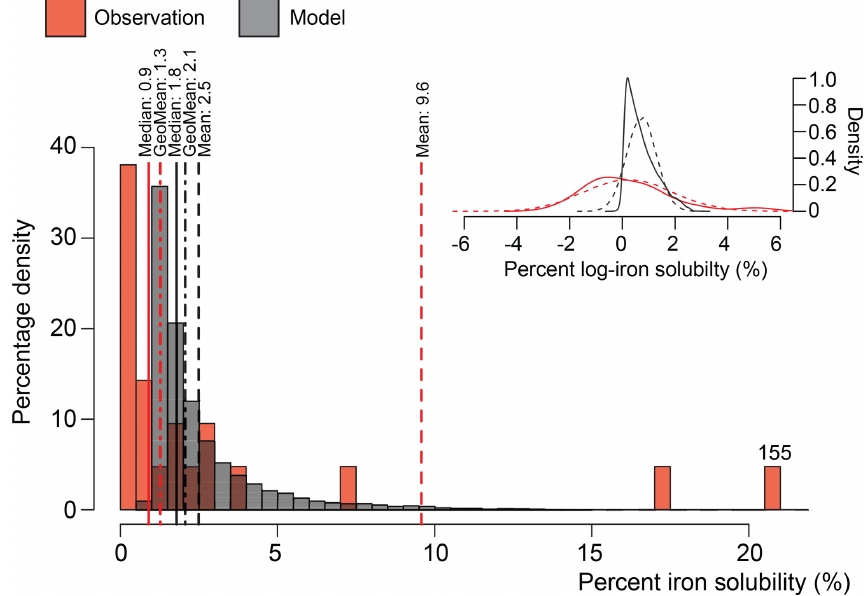
Figure 6. Histogram of observations ( n = 21) and daily model results (2007 to 2011) of iron solubility between 16 to 20 ◦ N and 27 to 32 ◦ W (one observation point and nine co-located model grid cells in Fig. 5). Mean (dashed lines), geometric mean (dot-dash lines), and median (full line) values shown the above respective dataset colour line. Note that the single observation value of 155% is off the scale and placed as such with the value given above. Insert: log plot for the same data (solid lines) with projected log-normal distribution from the mean and standard deviation of the data (dashed